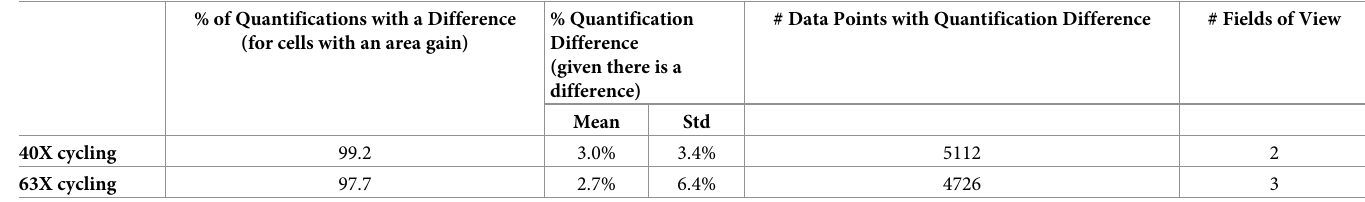
Table 3. Quantification difference in mean membrane intensity. % of Quantifications with a Difference (for cells with an area gain)